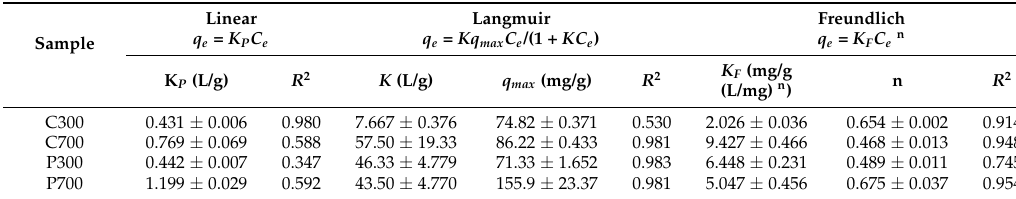
Table 4. Parameters for DBSA different adsorption isotherm